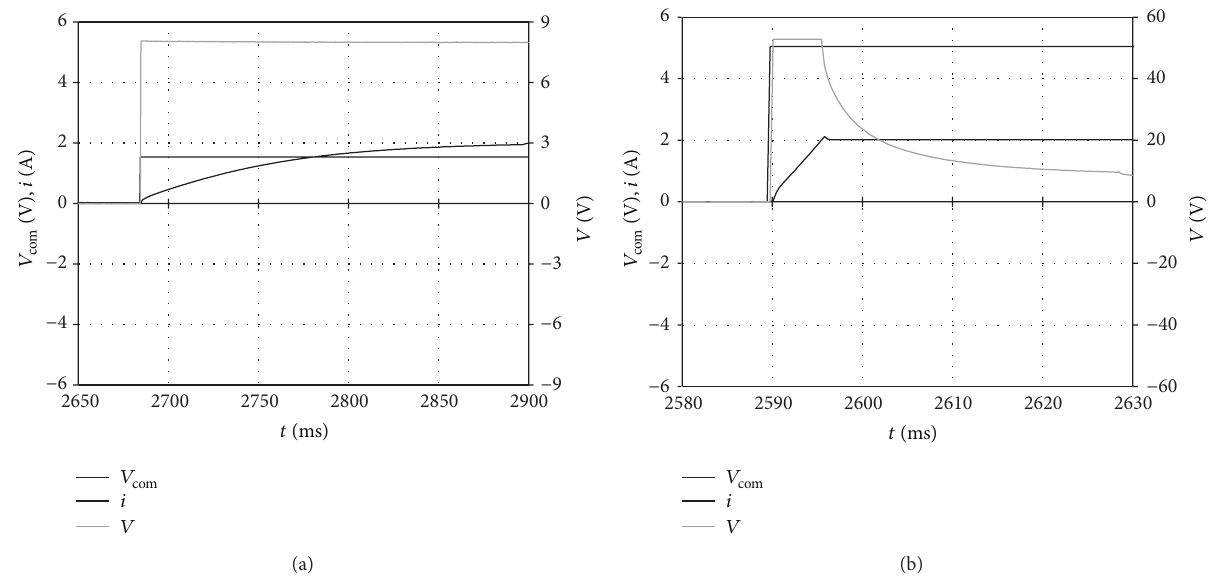
Figure 5: MR damper’s electrical behaviour when a “switch on” 0 → 2 A is imposed using a voltage-driven (a) or a current driven (b)